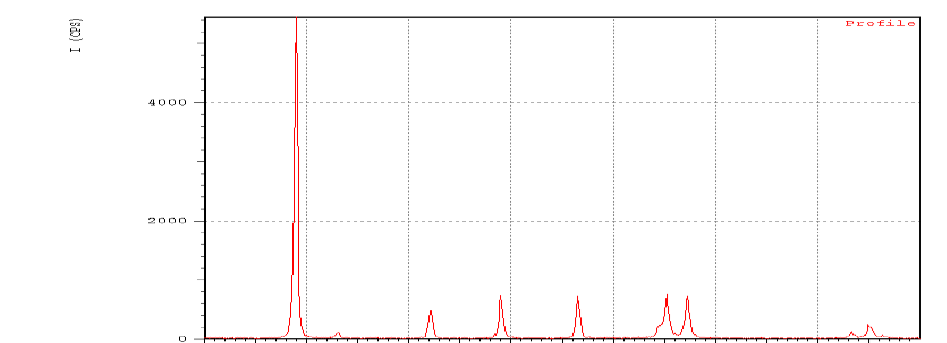
Fig.3: (a) The X- Ray diffraction of CaCO